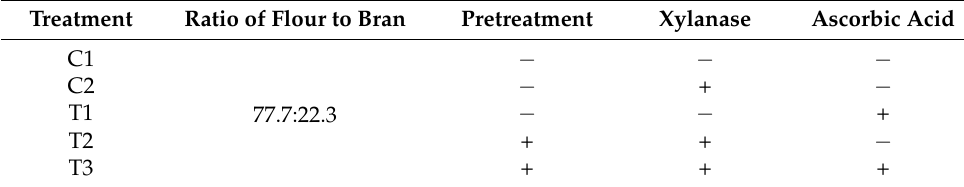
Table 1. Formulation of intermediate wheatgrass bread. Plus signs (+) denote the presence, minus signs denote ( − ) the absence of a conditioner or treatment.